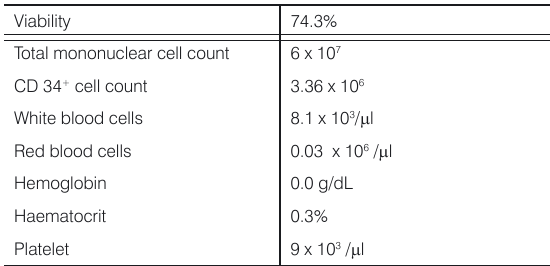
Table 1. Viability and cell count of the final bone marrow-derived stem cell solution (1